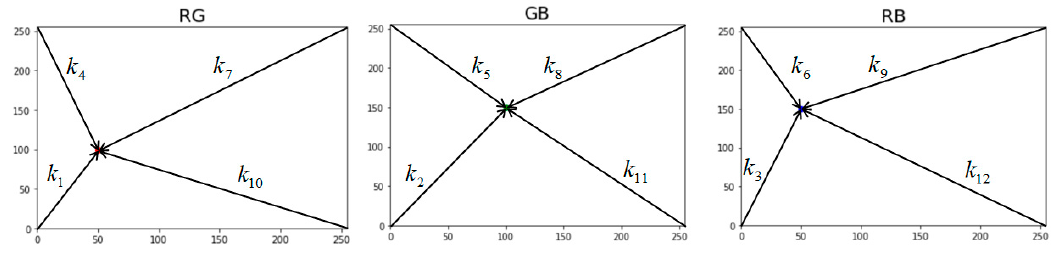
Figure 11. k1 – k12 feature schematic. Figure 11. k1–k12 feature